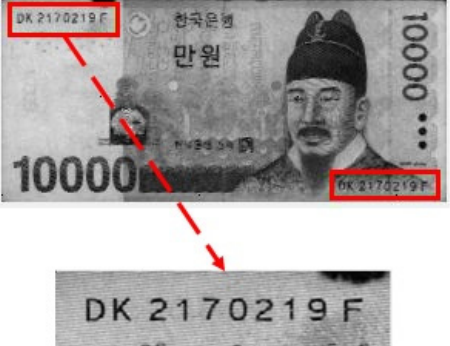
Figure 1. Example of a banknote serial number (KRW 10,000 bill).